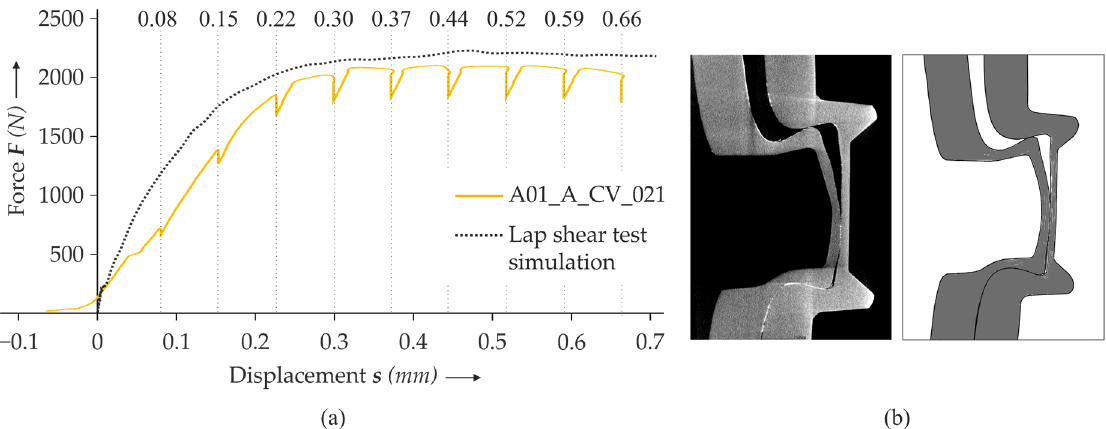
Figure 9. Comparison of the force–displacement curve of the in situ CT lap shear test (using a specimen with both sheets treated) with the simulation at the investigated displacements (in mm) ( a ). The comparison of the cross-section of the in situ CT lap shear test (both sheets treated) with the simulation at 0.66 mm displacement in detail ( b ).